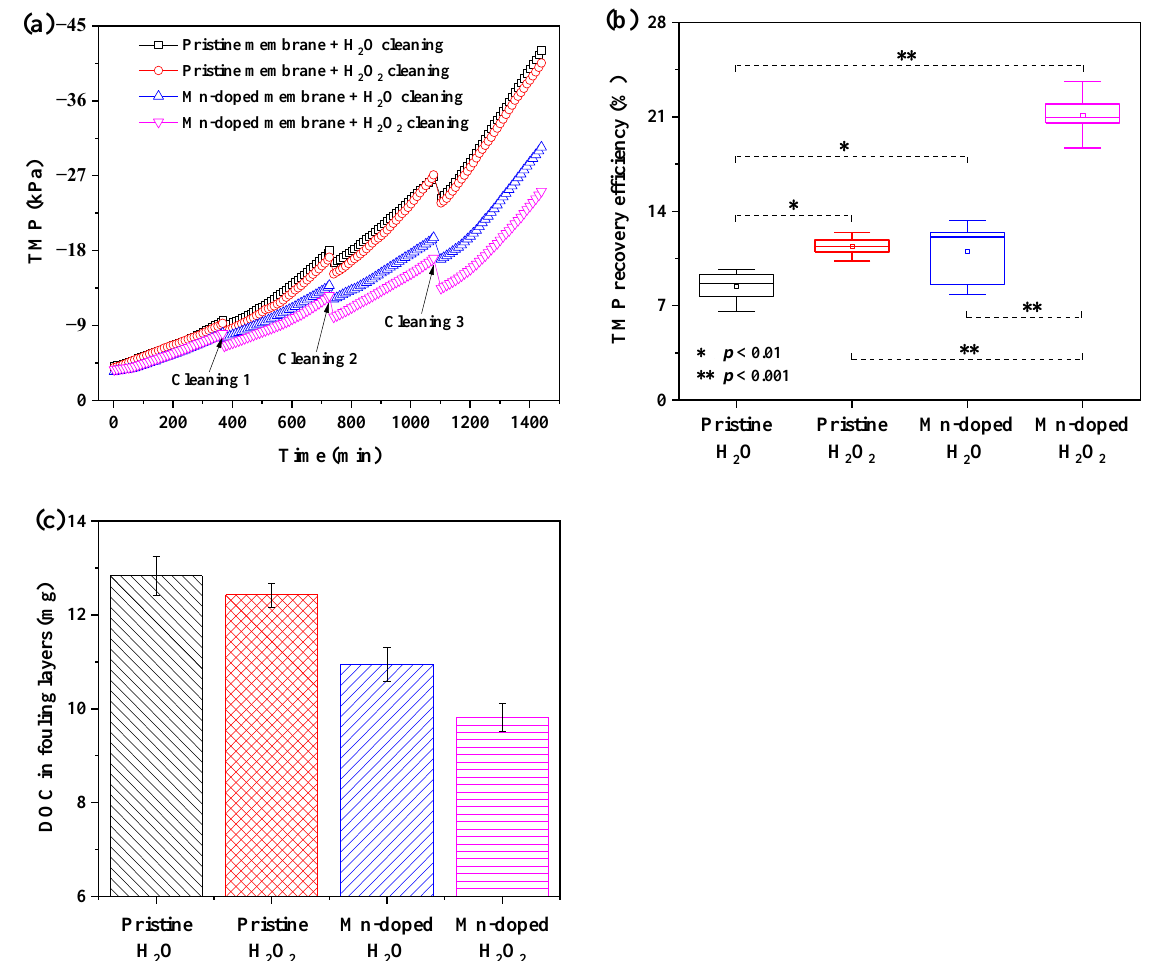
Figure 6. Membrane fouling mitigation behaviors of different membranes coupling with different in-situ cleaning methods. ( a ) TMP during filtration and cleaning; ( b ) TMP recovery efficiencies after cleaning; ( c ) the total content of DOC in membrane fouling layers after 24 hours filtration.